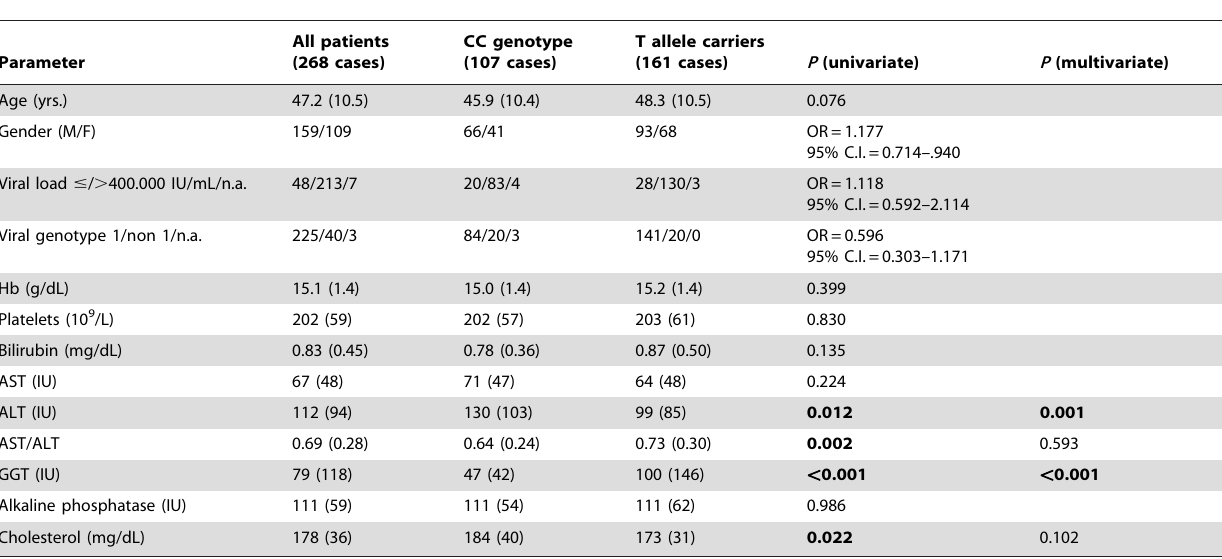
Table 1. Analysis of biochemical and virological parameters in relation with the rs12979860 genotype in 268 patients with chronic hepatitis